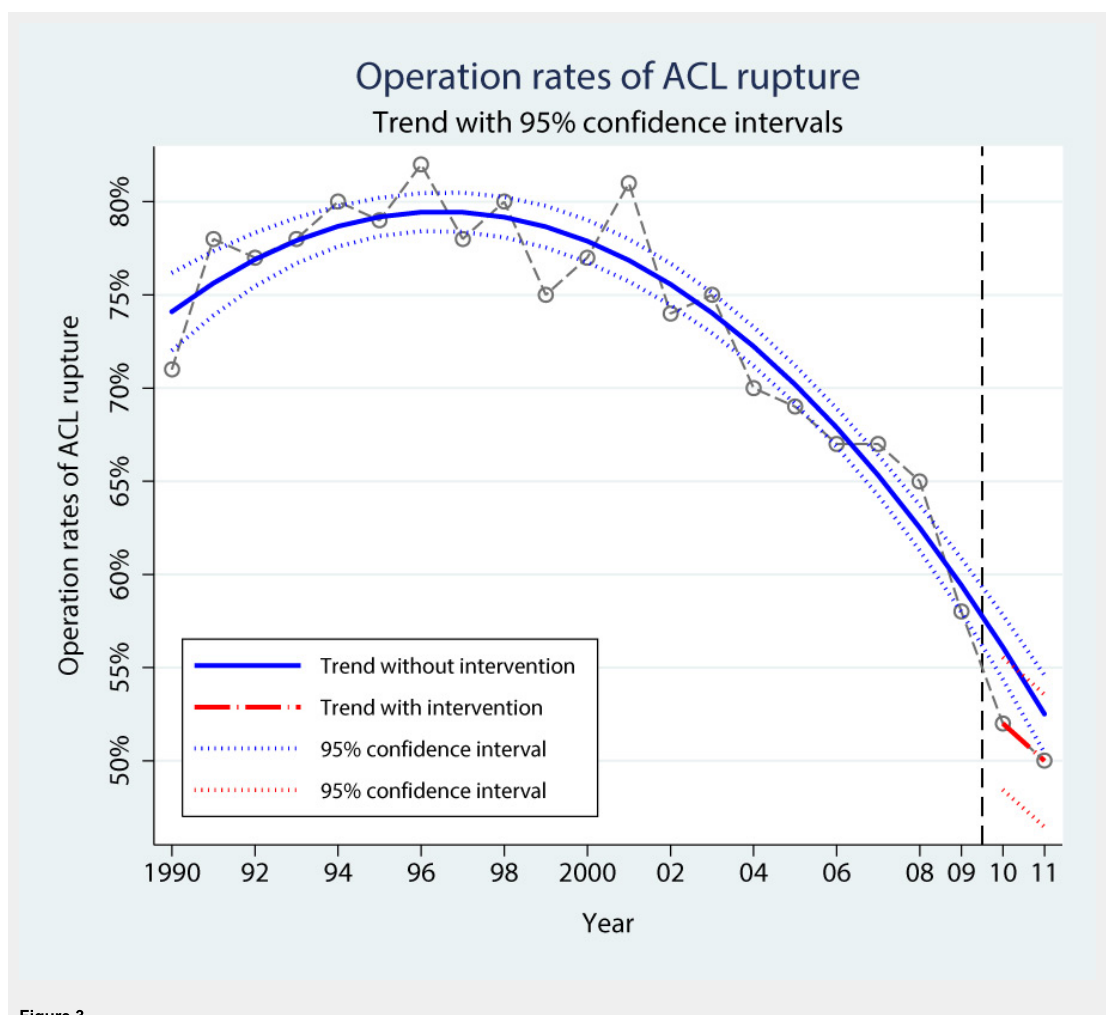
Figure 3 Operation rates of the ruptured anterior cruciate ligament (ACL) over time (1990–2011). Each data point represents the annual operation rate among patients with ruptured ACL (source: SSUV database). Vertical dashed line: Time point of Swiss Medical Board (SMB) report released in 2009. Blue solid trend line: Trend (95% CI) without SMB recommendations up to 2011. Red solid trend line: Trend (95% CI) after release of SMB recommendations in